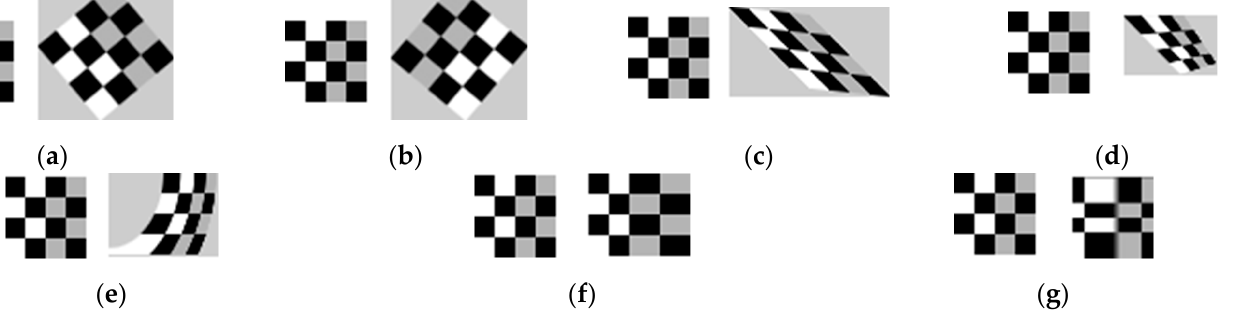
Figure 2. Examples of image deformations corresponding to each image transformation method: ( a ) non- reflective similarity; ( b ) similarity; ( c ) affine; ( d ) projective; ( e ) polynomial; ( f ) pwl; ( g ) lwm.